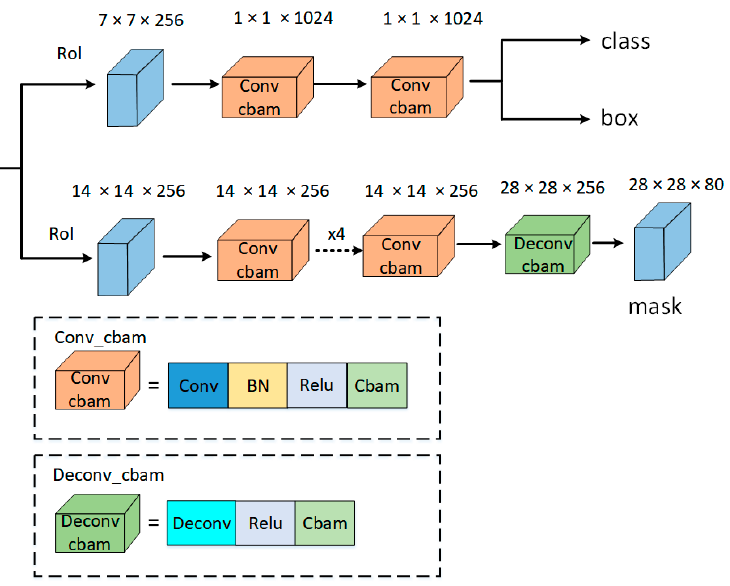
Figure 6. Head network of Mask R-CNN with attention mechanism